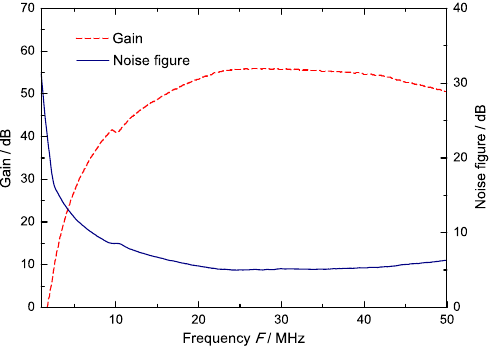
Figure 9. Gain and noise figure of the analog signal chain based on the gated amplifier.